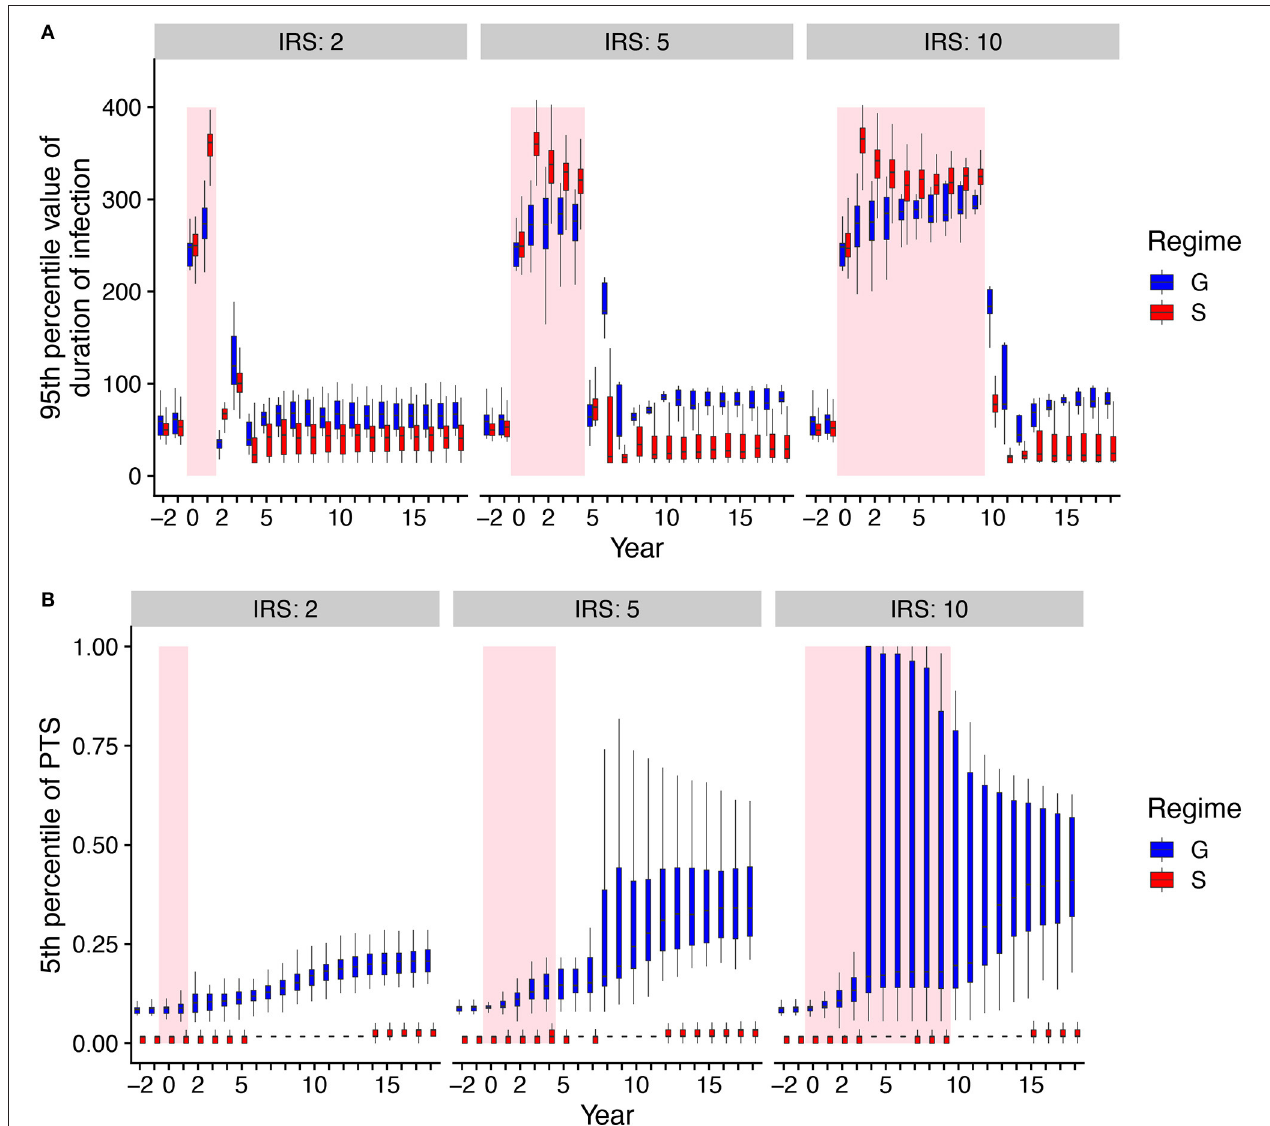
FIGURE 3 | Comparisons of duration of infection and mean PTS over time under high transmission between the two regimes with and without NFDS. Boxplots summarize the distribution among replication runs of the 95th percentile of duration of infection (A) , and the distribution of the 5th percentile of PTS between var repertoires (B) . We therefore focus on the longest periods of infection duration and correspondingly, the most dissimilar parasites. Shaded areas indicate the intervention (IRS) period. Negative years correspond to times prior to